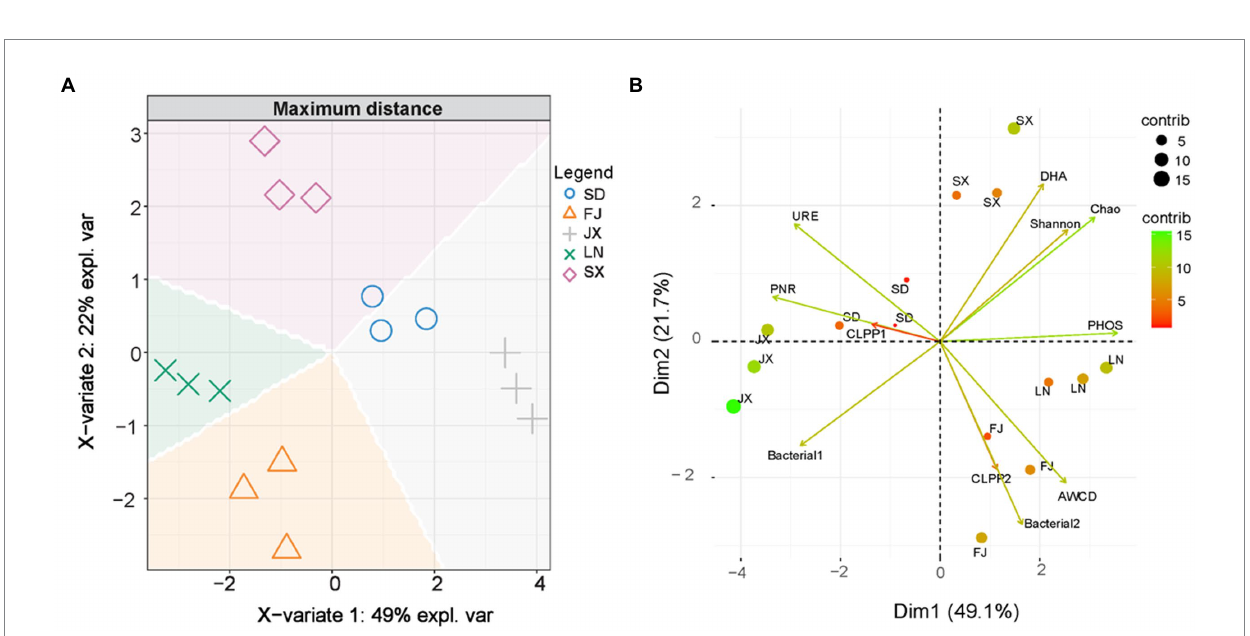
FIGURE 5 Graphic plots of discrimination analysis (A) , where, expl. var is the abbreviation of explanation of variation and principal component analysis (B) on soil integrative microbial